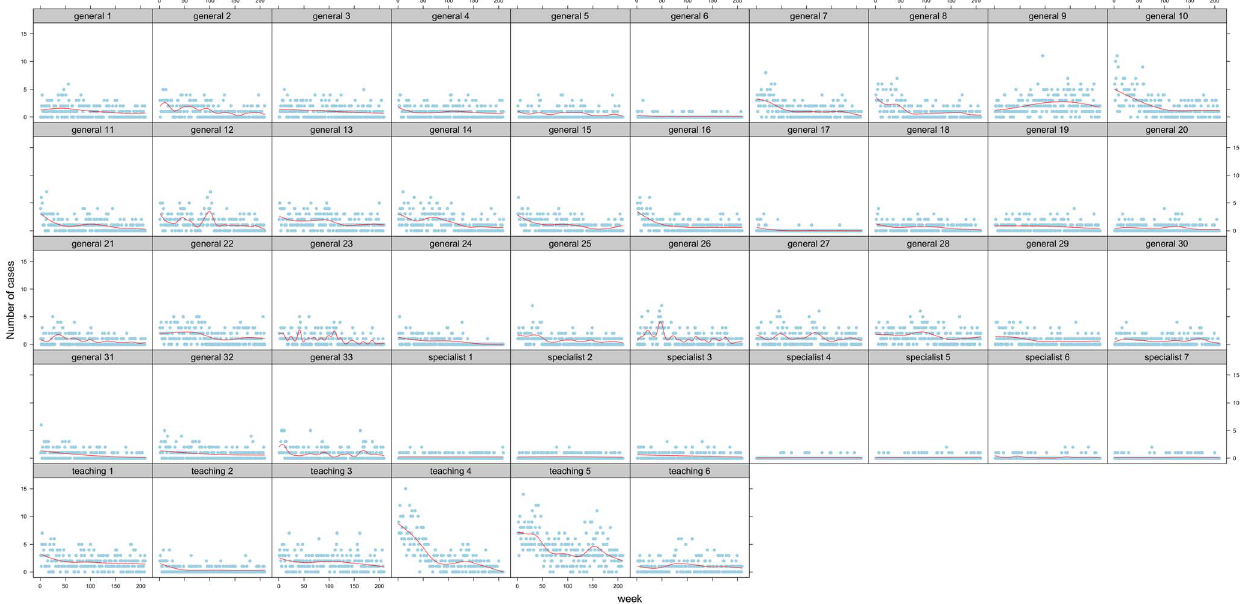
Figure 1. Observed weekly number of CDI per hospital over the four-year study period. Grey dots represent the weekly-observed CDI cases within all hospitals from April 2008 to March 2012. X-axis: Week 0 corresponds to the first week of April 2008 and week 209 to the last week of March 2012. Red line: the incidence trend over time illustrated by cubic smoothing spline fit (for illustration).